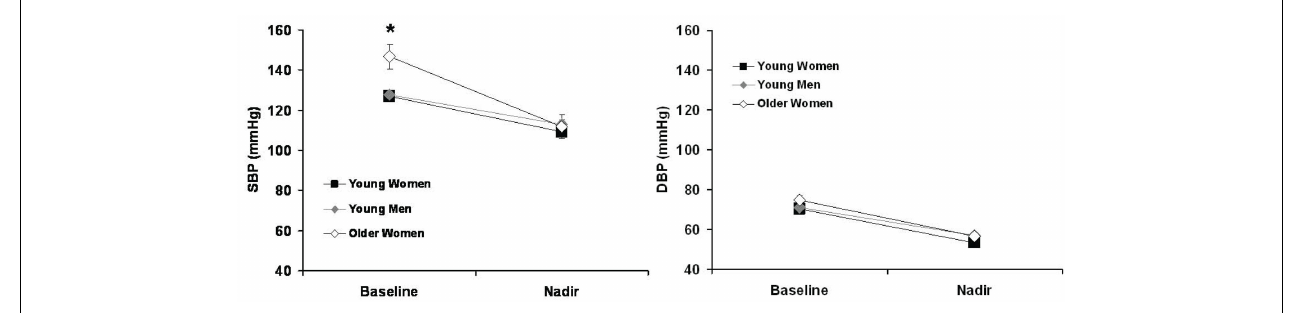
FIGURE 2 | Baseline and nadir SBP and DBP of young women, young men, and older women. * p < 0.05 vs. young women and young